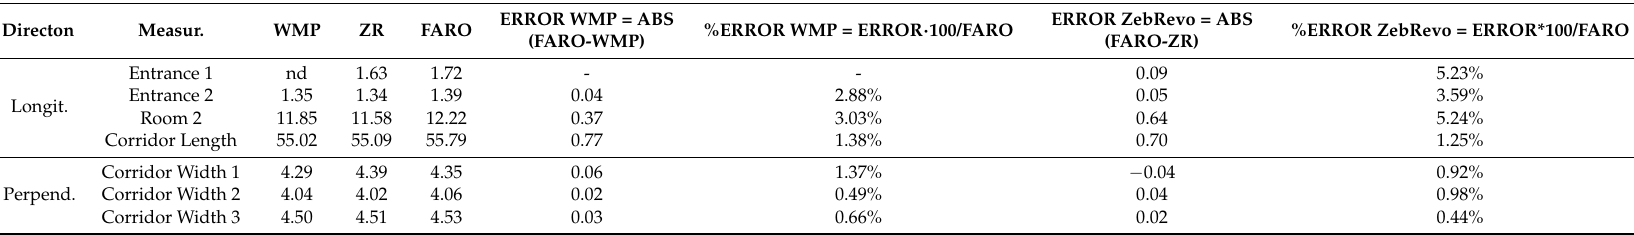
Table 7. Results of the 2D measurements for case study 2, in meters. Column 6 stands for Error of the wearable prototype (in the following, WMP), as the absolute difference between the distance measure in the point cloud from the FARO laser scanner and the WMP. Column 7 includes the relative error (in percentage) of the point cloud from the WMP, referred to the distance measured by the FARO as ground-truth. Columns 8 and 9 present the same absolute errors and relative errors, for the Zeb-Revo device (denoted as ZR). Direct Longit. Perpend.